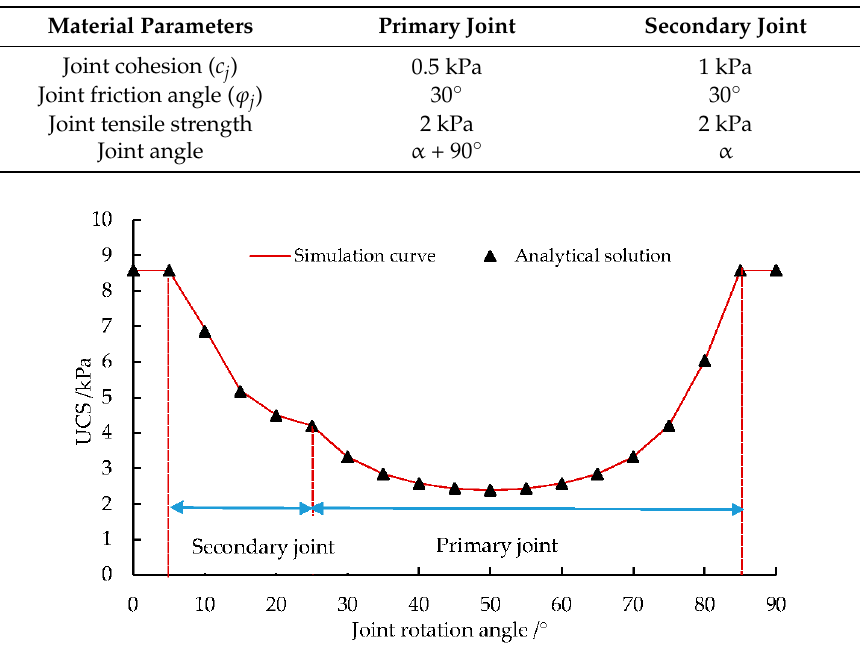
Table 4. Mechanical properties of jointed rock mass (different joint cohesion).